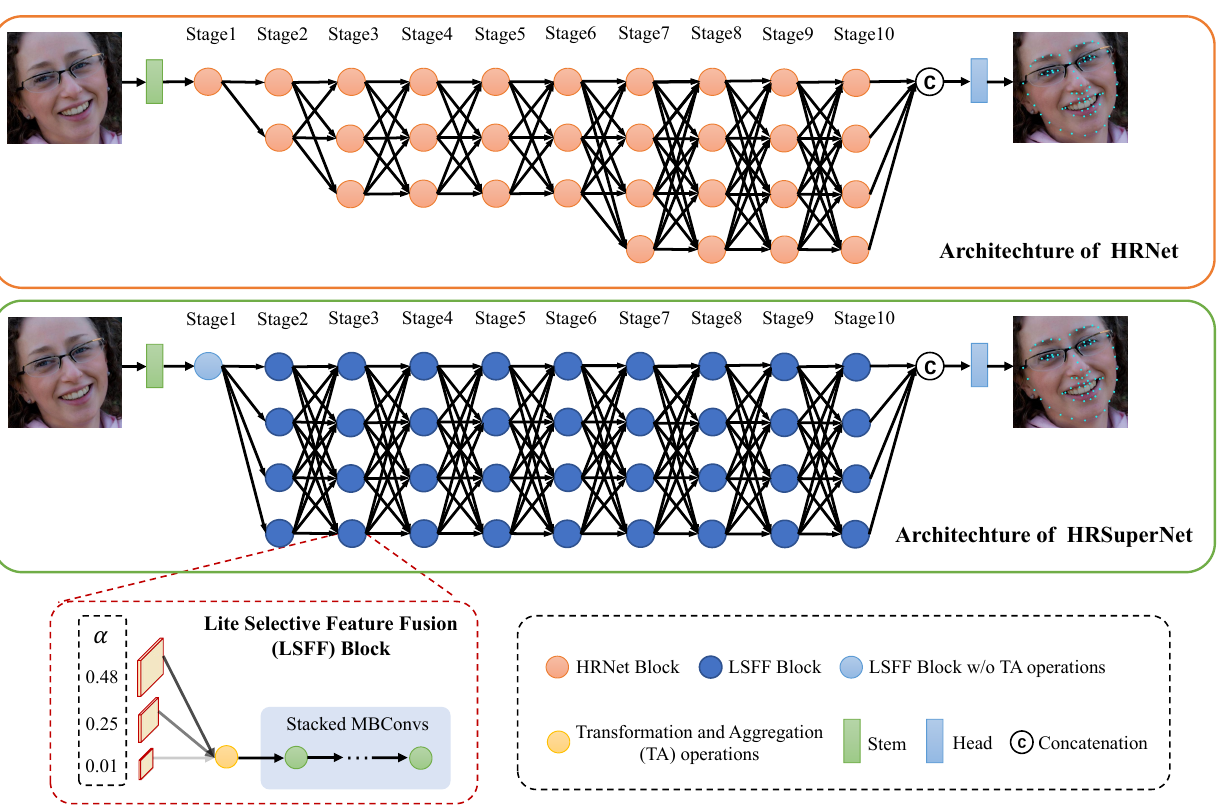
Figure 3. Detailed structures of HRNet and HRSuperNet. The proposed lightweight selective feature fusion (LSFF) block is composed of the transformation and aggregation (TA) operations with different importance factors α and stacked mobile inverted bottleneck convolutions